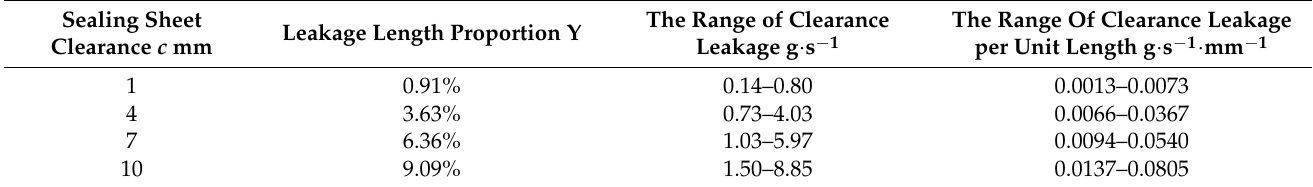
Table 5. The range of clearance leakage ( a = 1.0 mm).